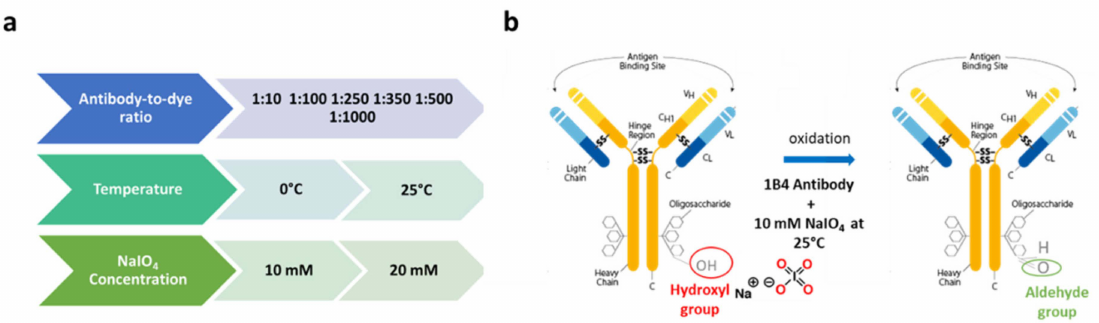
Figure 3. Optimization parameters: (i) antibody-to-dye ratio for the labeling, (ii) temperature, and (iii) NaIO 4 for the oxidation reaction ( a ). Graphical representation of the optimized protocol ( b